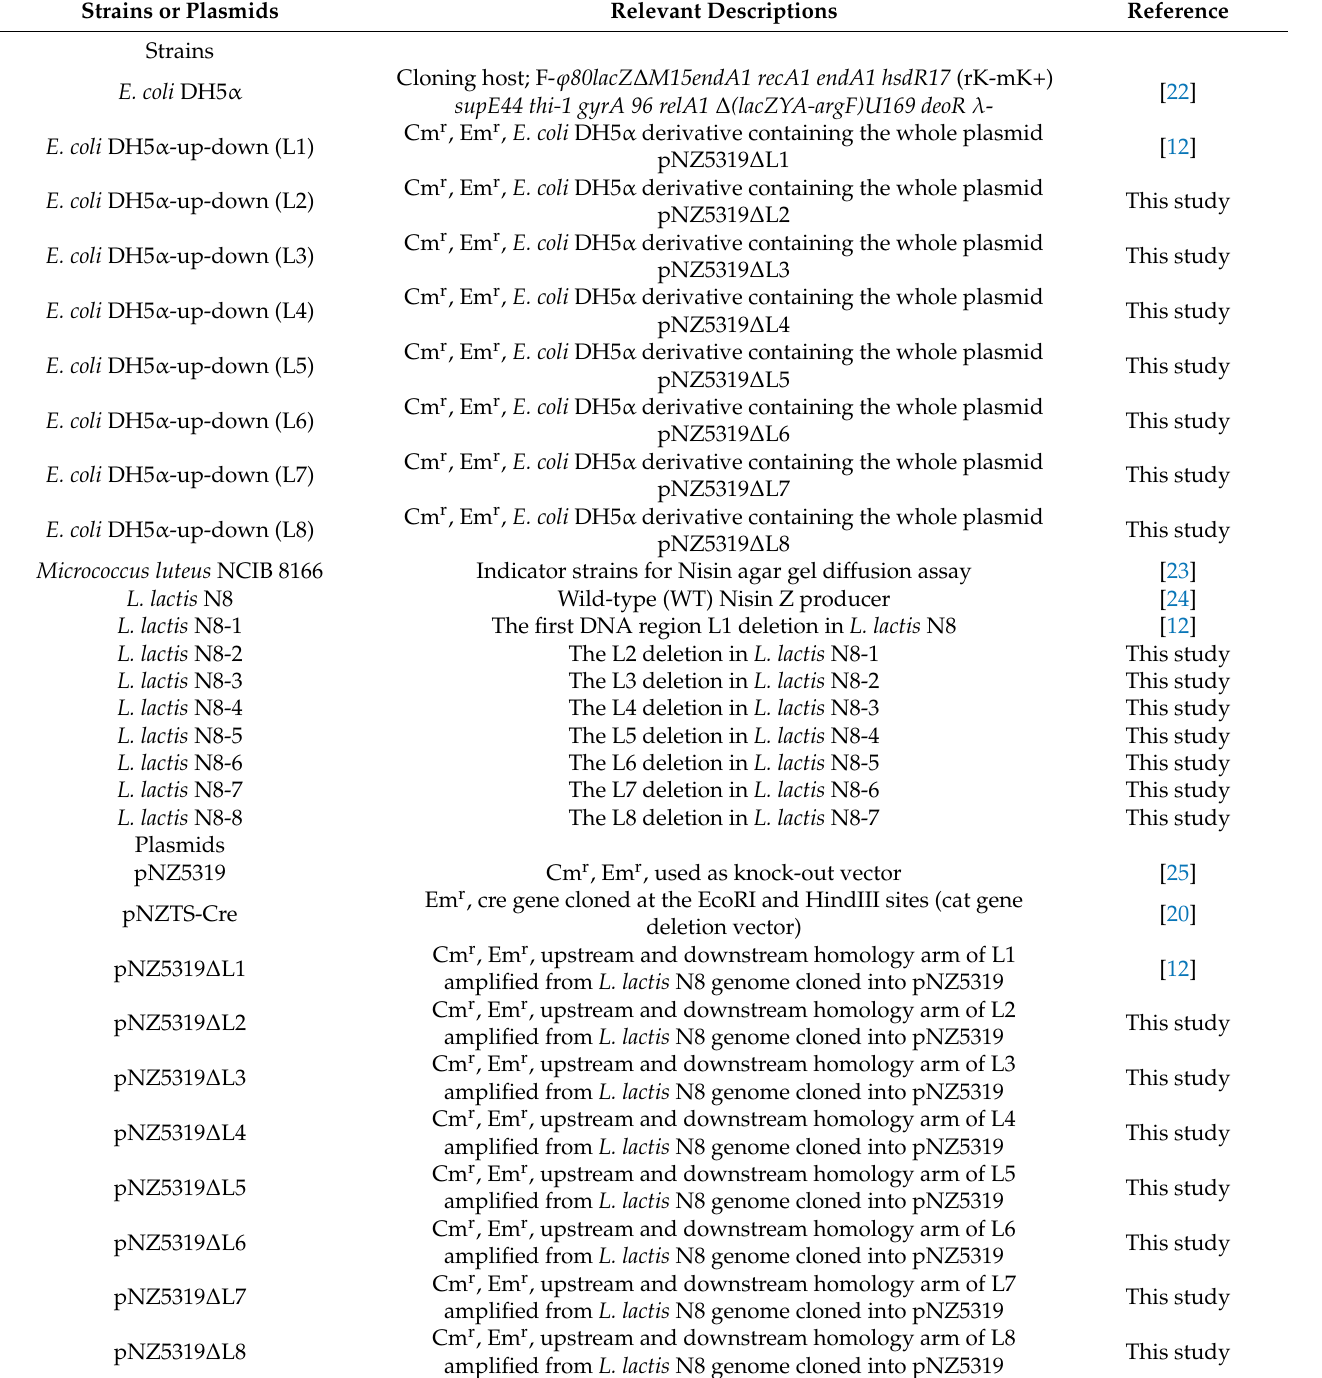
Table 1. Bacterial strains and plasmids utilized in this